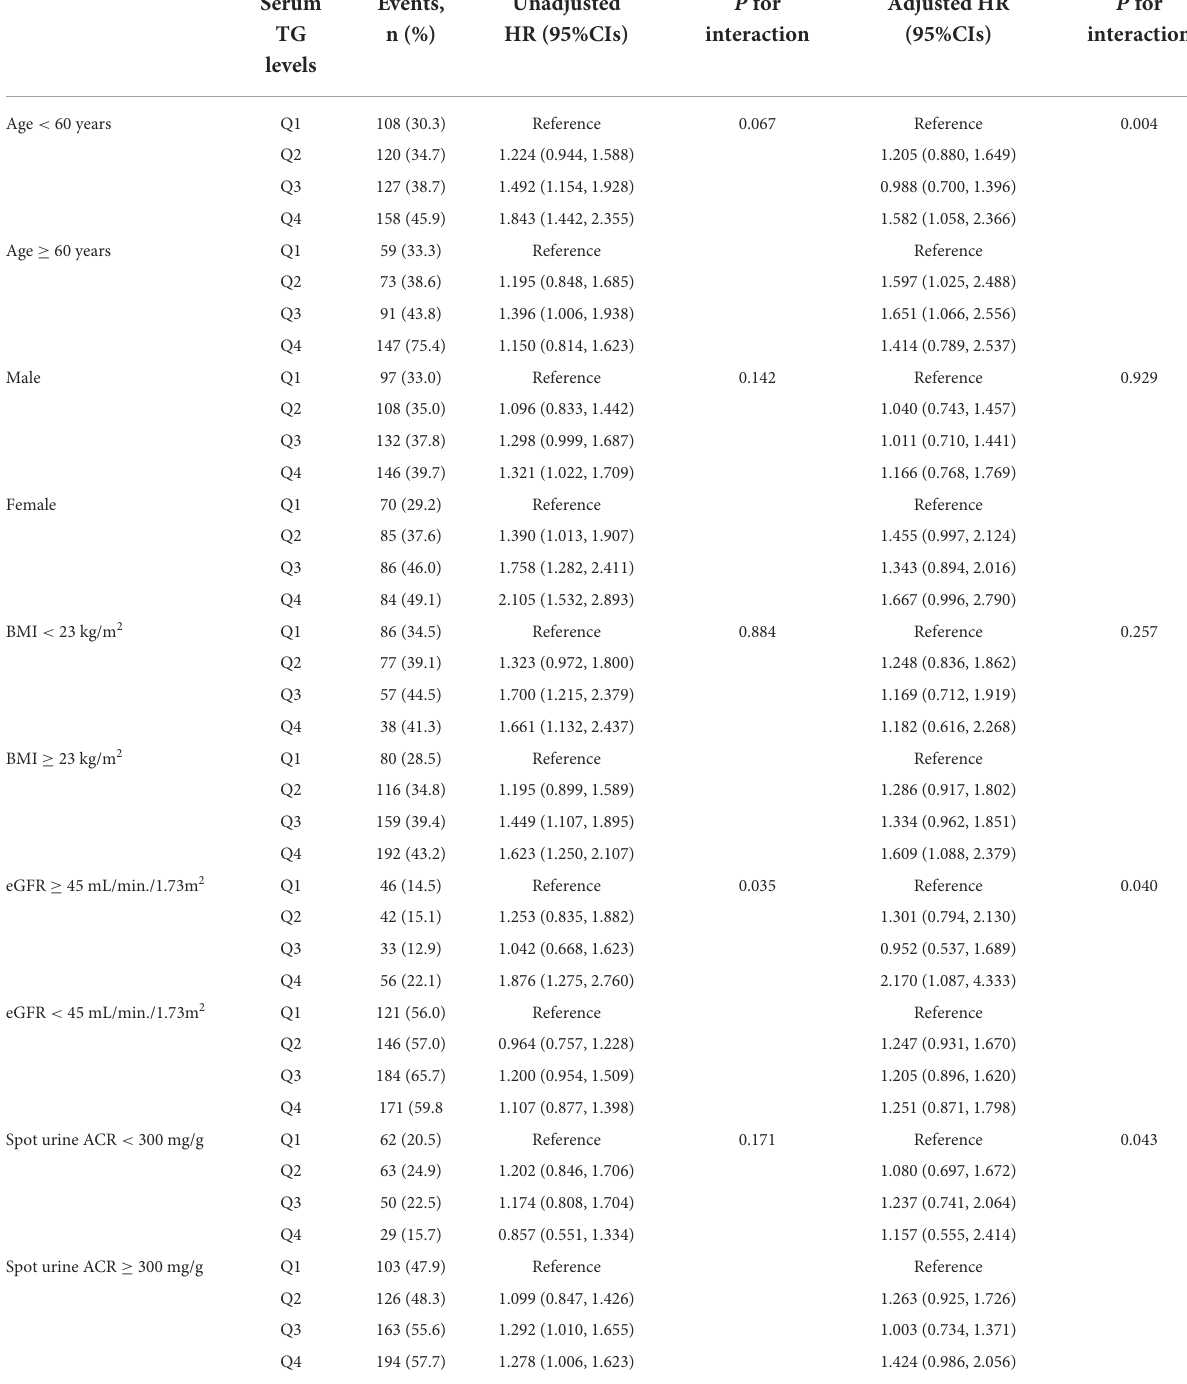
TABLE 4 Cox regression analysis of serum TG levels for composite renal events in various subgroups.